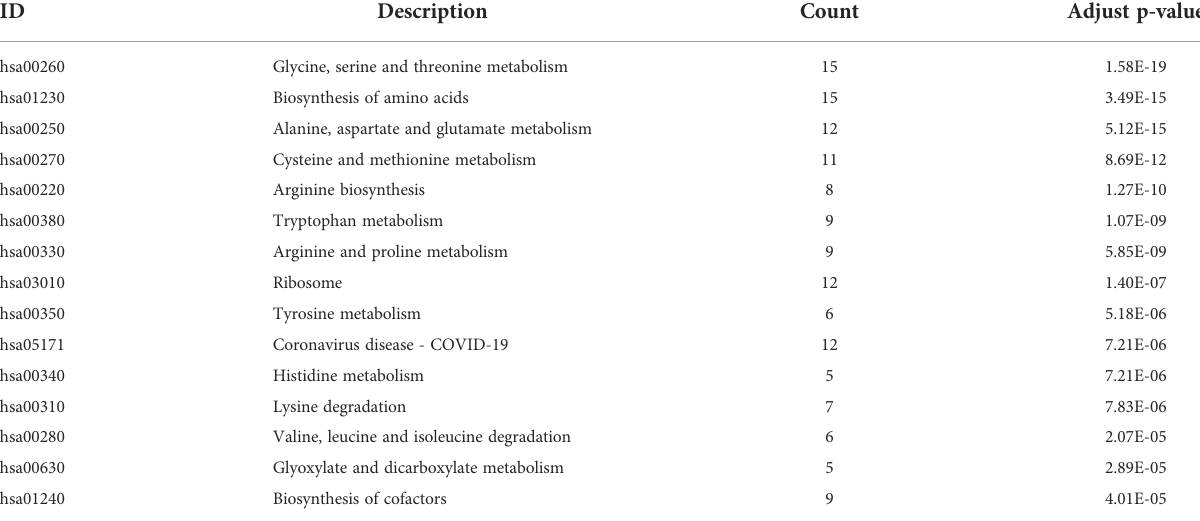
TABLE 2 KEGG enrichment results of differentially expressed AAMRGS.